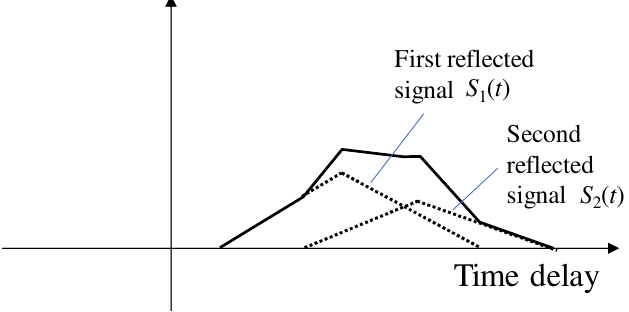
Figure 4. Correlation function of an NLOS multipath